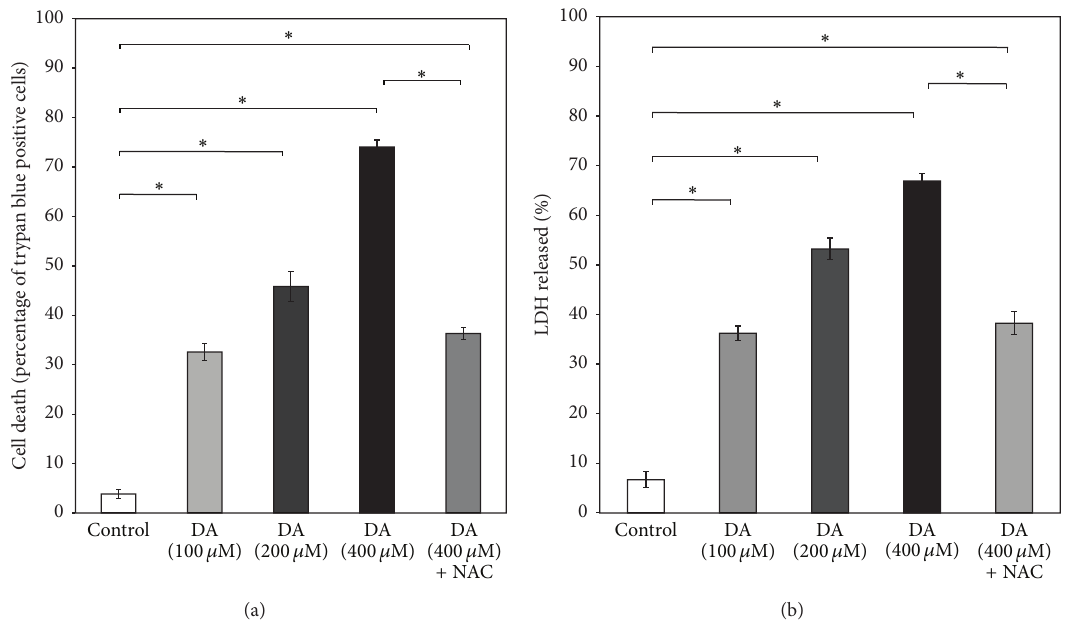
Figure 1: Dose-dependent effects of DA on SH-SY5Y cell-viability. SH-SY5Y cells were treated without (control) or with varying concentrations of DA (100–400 𝜇 M) for 24 h in the presence or absence of NAC (2.5 mM), and the cell viability was measured by (a) trypan blue assay or (b) estimation of LDH activity, as described in Section 3. Values are the means ± SD of six observations. Statistically significant differences in cell death among the groups exist at 𝑃 < 0.001 as shown by asterisks ( ∗ ) (in (a), 𝐹 (4,25) = 1177.09, 𝑃 < 0.001 ; in (b), 𝐹 (4, 25) = 898.99. 𝑃 < 0.001 ).